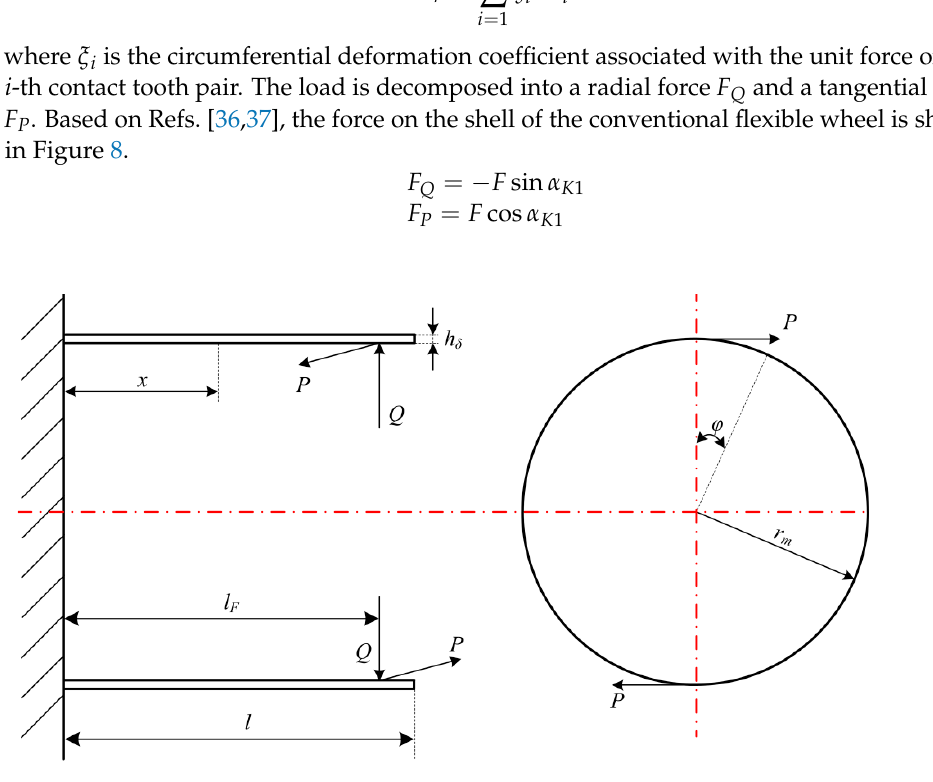
Figure 8. Force on the conventional flexible wheel shell [36,37]. The radial, circumferential, and axial displacement under load can be determined with